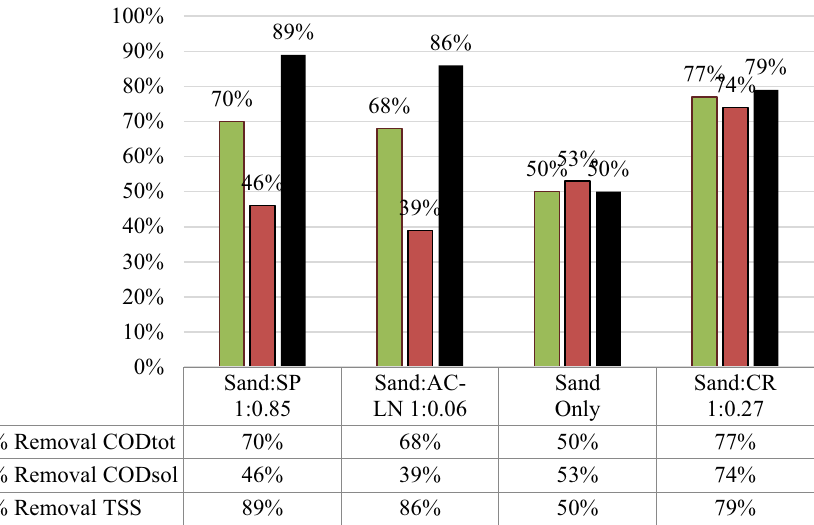
Fig. 18 Comparison among dif- ferent media mixed with